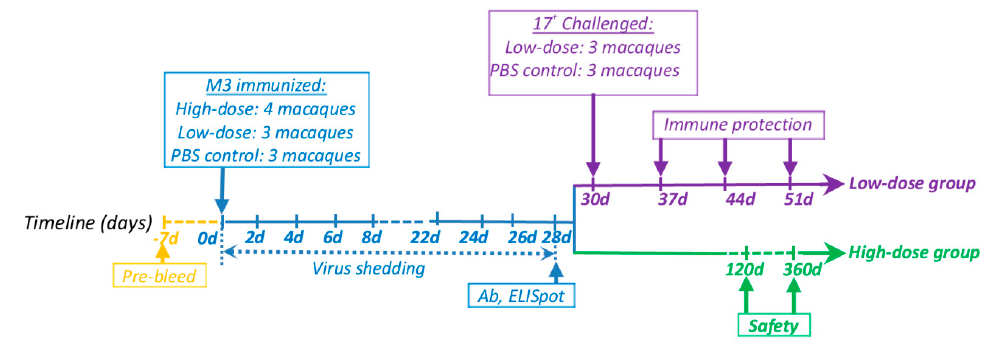
Figure 1. The schematic overview of the experimental process.